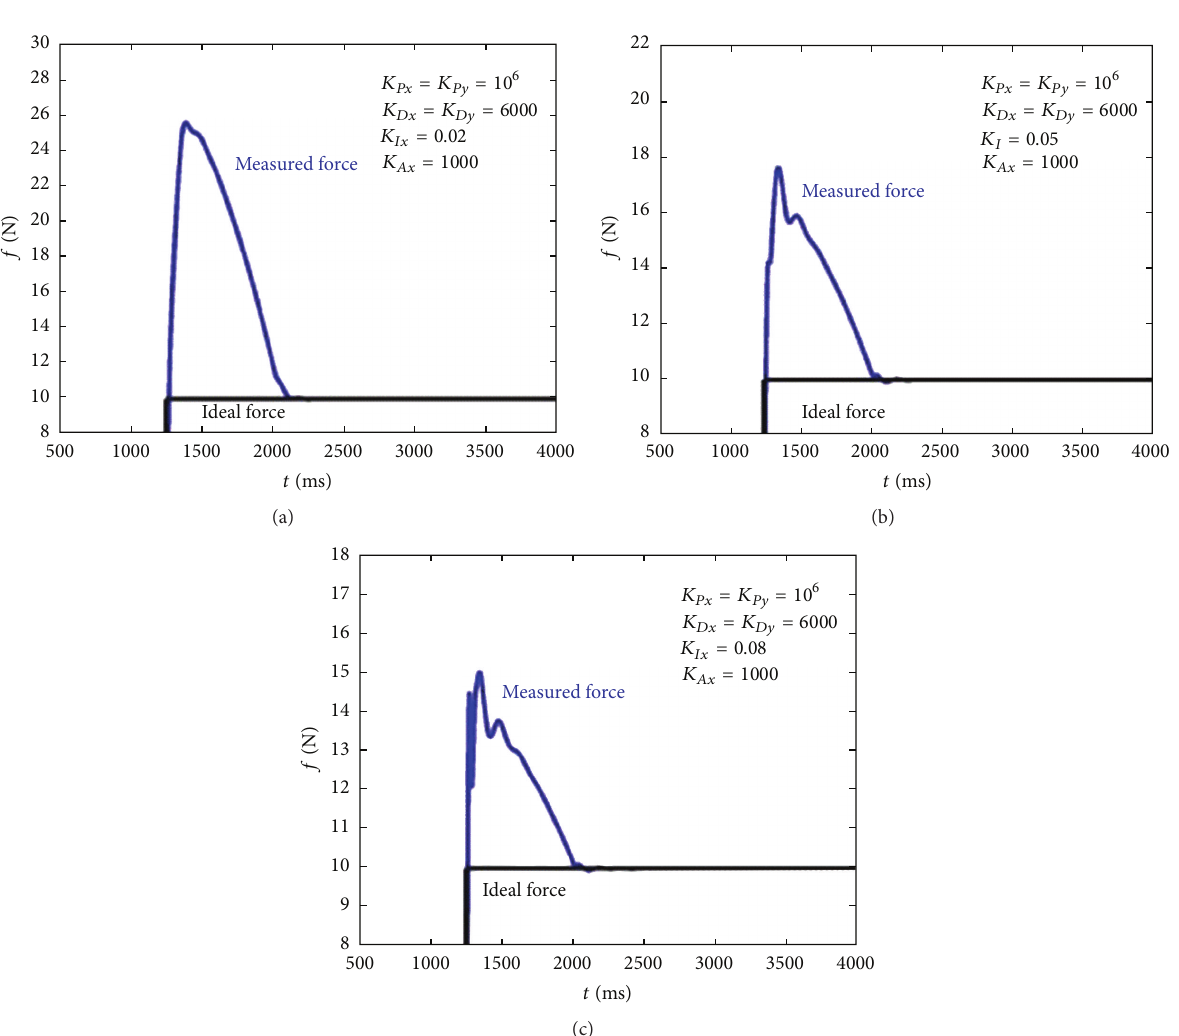
Figure 24: End-Effector force value (N) varying the 𝐾 𝐼 gain in the P system: (a) 𝐾 𝐼 = 0.02 ; (b) 𝐾 𝐼 = 0.05 ; (c) 𝐾 𝐼 = 0.08 .